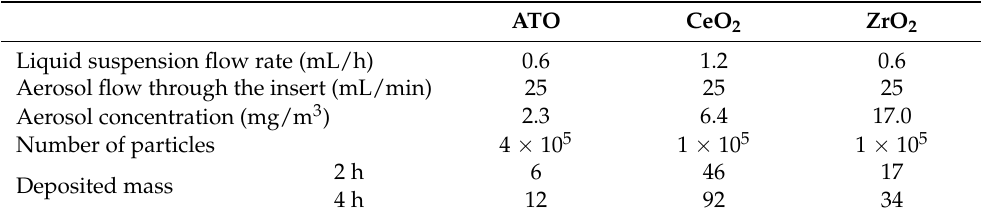
Table 2. Aerosolisation conditions and exposure concentrations of the tested aerosolised engineered nanoparticles in human alveolar epithelial-like cultures.